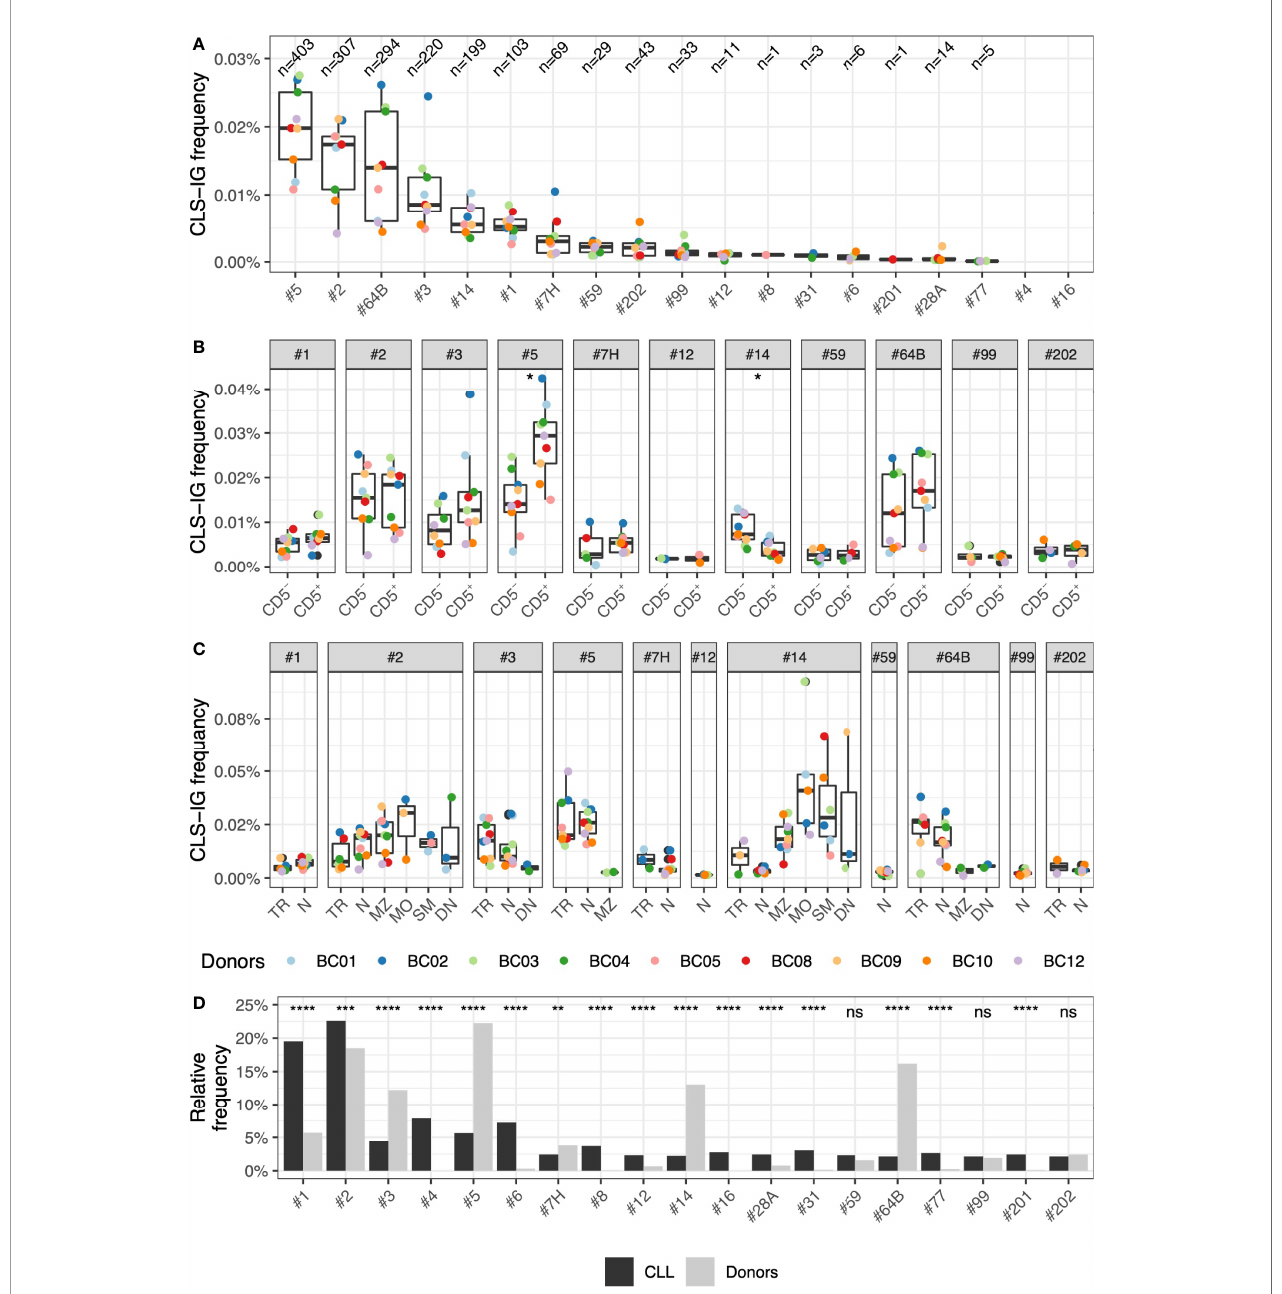
FIGURE 4 | Frequency of CLS-IG subsets. (A) Frequency of CLS-IGs for individual CLL subsets in healthy donors among all IGHV-IGHD-IGHJ clonotypes. (B) Frequency of CLS-IGs for each CLL subset in CD5 + and CD5 - B cells. Frequency data derived from only one donor was not considered informative and not plotted. Paired Wilcoxon test was performed, only signi fi cant statistics are shown (*p ≤ 0.05). (C) Frequency of CLS-IGs for each CLL subset in B cell subsets. Frequency data derived from only one donor was not considered informative and not plotted. (D) Frequency of CLS-IGs for individual CLL subsets among all CLS- IGCLL subset frequency of CLS-IGs relative frequency compared with CLL stereotyped clones (6). Binomial test was performed, only signi fi cant statistics are shown (*p ≤ 0.05, **p ≤ 0.01, ***p ≤ 0.001, ****p ≤ 0.0001; ns, not signi fi